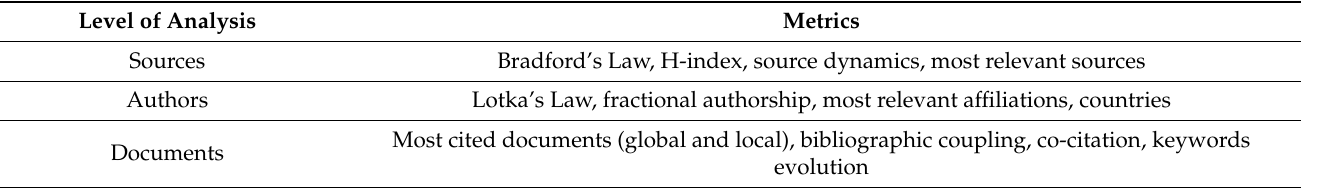
Table 3. Analysis methodology table for mapping the field of VRP/PSO